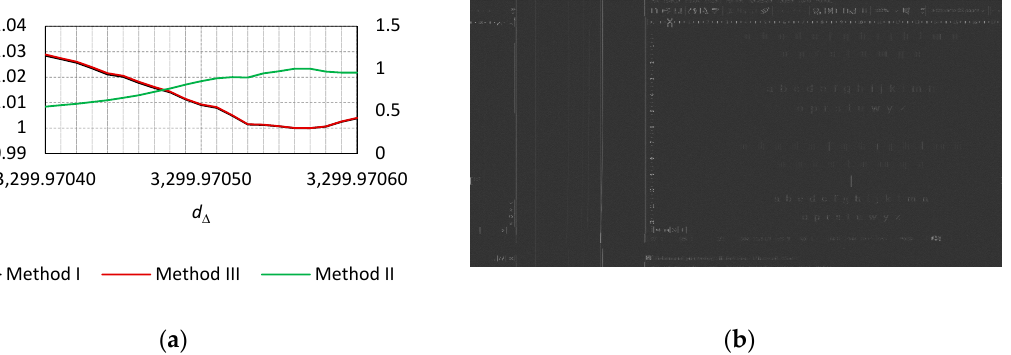
Figure 29. ( a ) The normalized values of the adopted measures (method I, II and III) calculated in domain of image line length d ∆ for the accuracy ∆ = 0.00001 (for the original image shown in Figure 7d) and ( b ) image reconstructed on the basis of the recorded revealing emission signal at frequency f o = 740 MHz (receiving bandwidth BW = 50 MHz) for estimated line length d ∆ = 3299.97057 (accuracy ∆ = 0.00001)—multiple of image summation Sum MTL = 60, the source of revealing signal emission—display monitor, VGA standard.